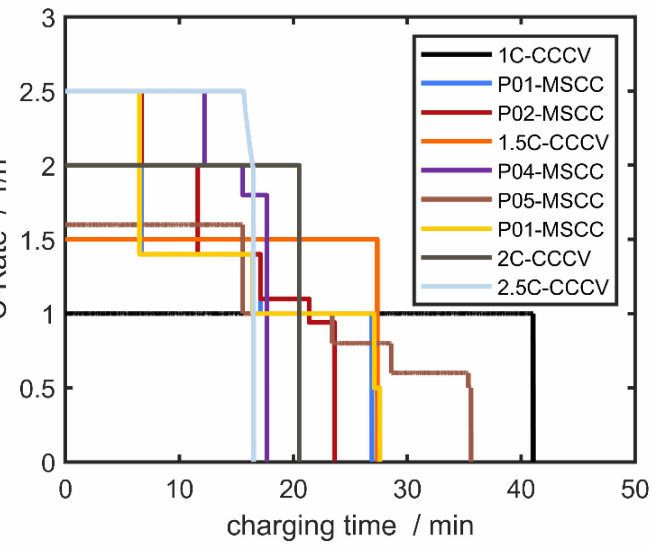
Figure 1. Overview of the various fast-charging profiles applied in this study: simple constant current–constant voltage charging (CCCV) and multi-step constant current charging (MSCC).